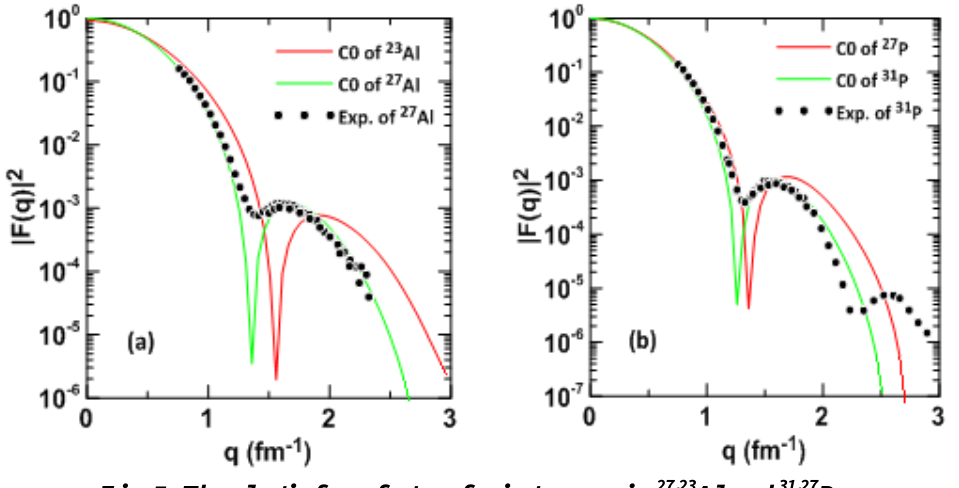
Fig. 5: The elastic form factors for isotopes pairs 27,23 Al and 31,27 P.